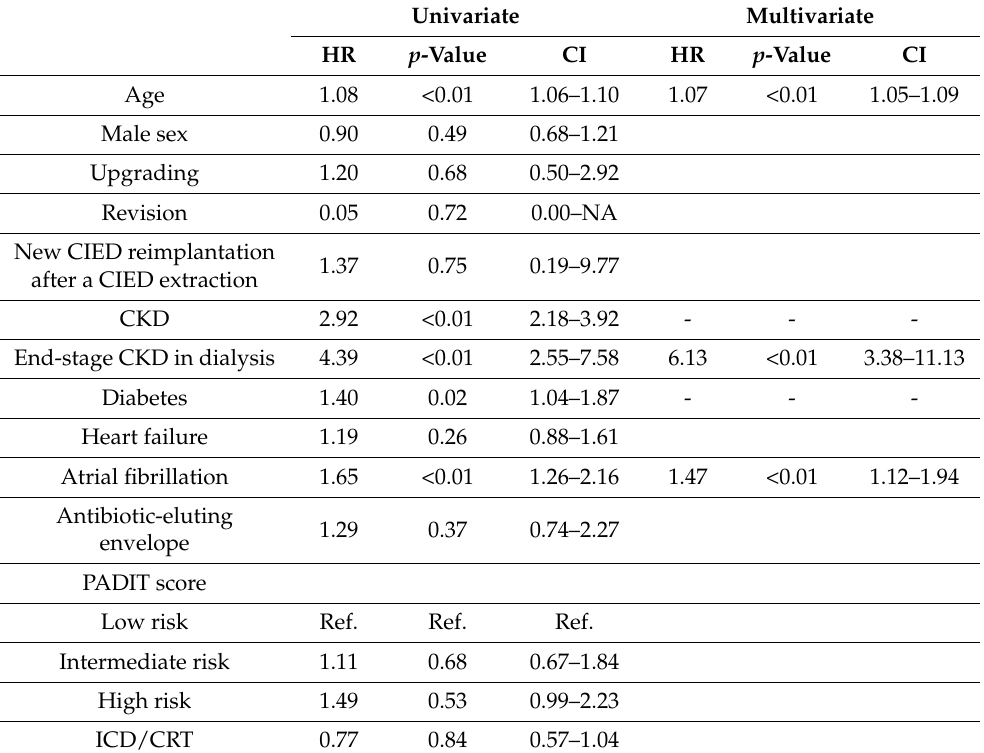
Table 3. Univariate and multivariate Cox’s regression analysis for all-cause